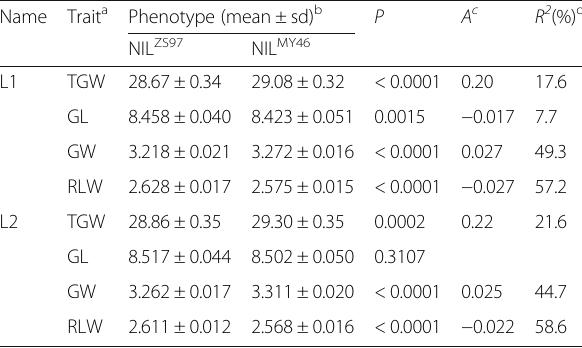
Table 2 Validation of qTGW1.2c using two sets of near isogenic lines in BC 2 F 11:12